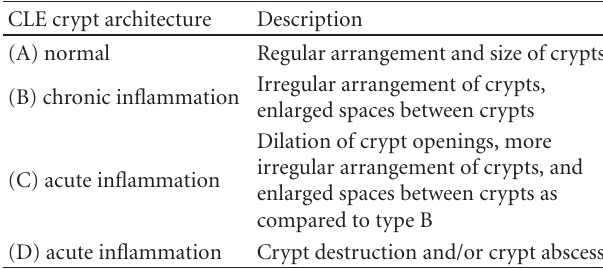
Table 2: Microvascular architecture by e-CLE assessment in ulcerative colitis [7].